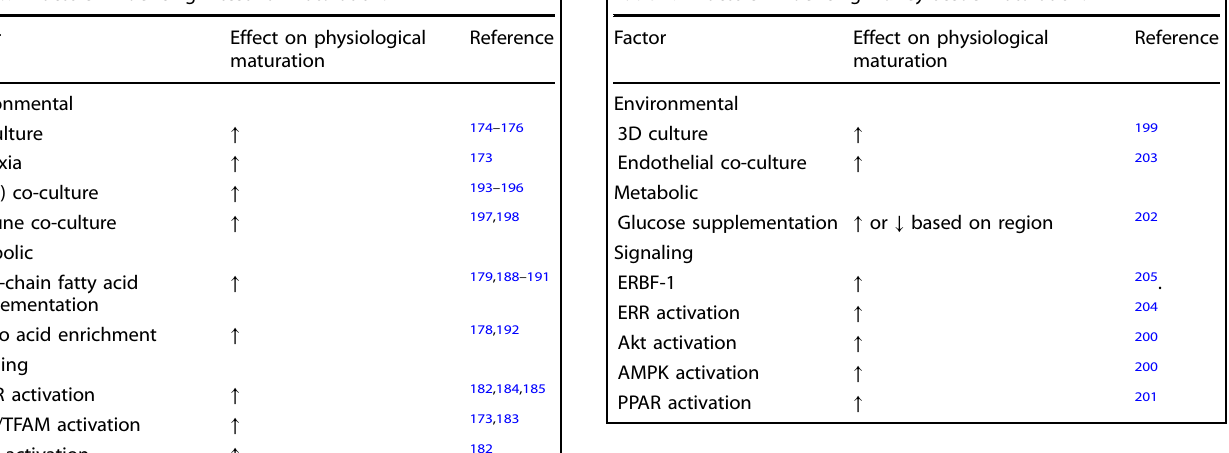
Table 6. Factors in fl uencing intestinal maturation. Table 7. Factors in fl uencing kidney tissue